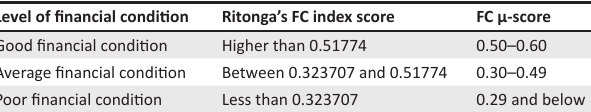
TABLE 5: Principal component analysis. TABLE 4: Comparing Ritonga’s index to the financial condition index.